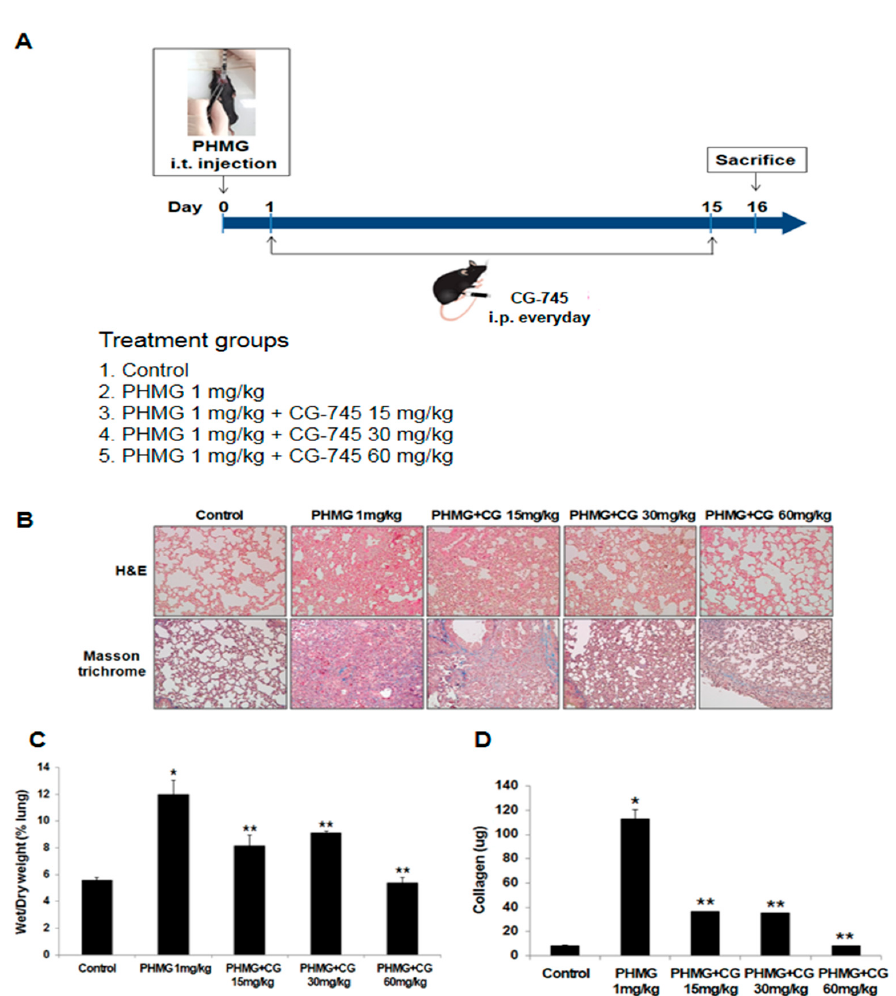
Figure 4. CG-745 ameliorates pulmonary fibrosis induced by PHMG in mice. ( A ) Mice were instilled with polyhexamethylene guanidine (PHMG) (1 mg / kg) intratracheally on day zero only, and then CG-745 (15 mg / kg, 30 mg / kg or 60 mg / kg) was intraperitoneally administered daily for 14 days. ( B ) Representative histological sections from lung tissues stained with hematoxylin and eosin (H&E) or Masson’s trichrome staining were shown from control, PHMG, and PHMG + CG-745 (15 mg / kg, 30 mg / kg, or 60 mg / kg) group (magnification, × 200). ( C ) The wet / dry measurement was used to detect pulmonary edema. ( D ) Collagen content in the lung tissues was measured by a Sircol assay. Data are presented as mean ± SD, n = 5. * p < 0.01 versus control group. ** p < 0.05 versus PHMG group.